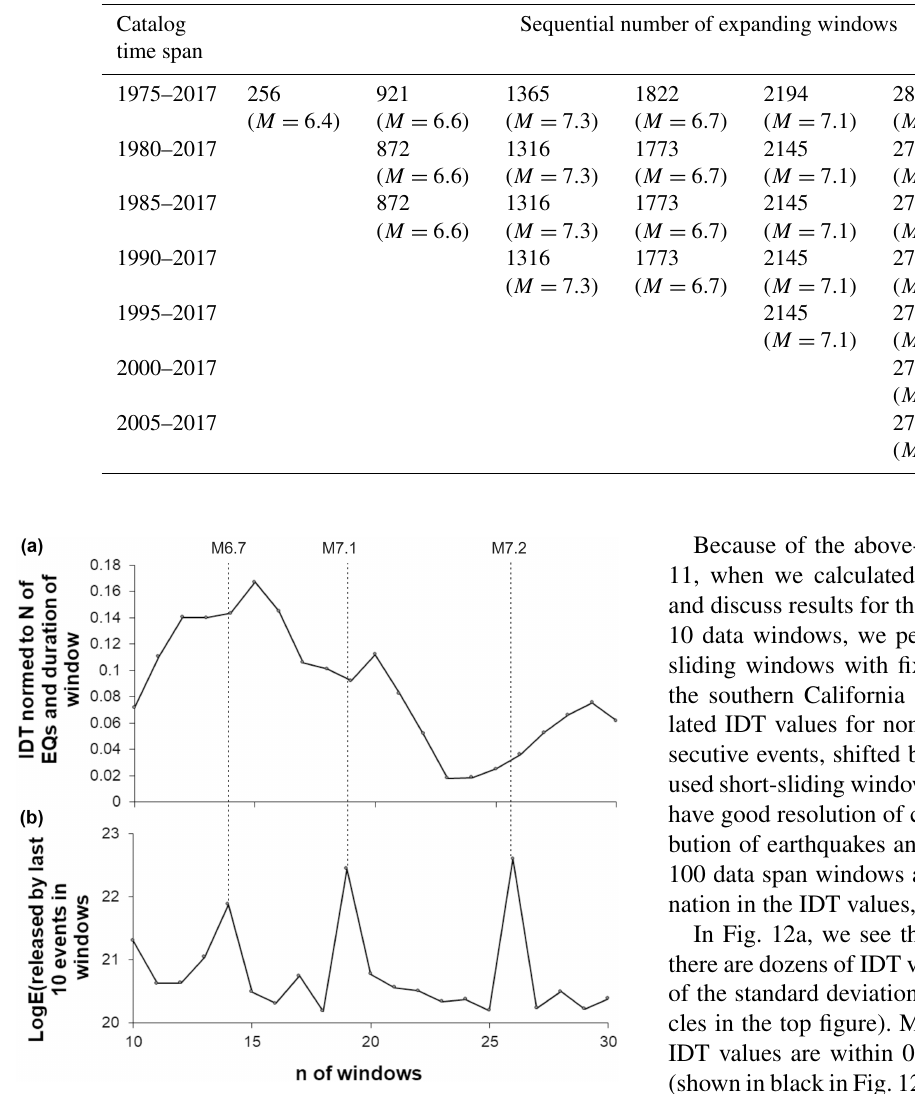
Figure 11. Calculated for the expanding (by consecutive 10 data) windows, integral deviation times (IDTs) (a) and the increments of seismic energies released by 10 last events in consecutive win- dows (b) obtained from the southern California earthquake catalog (above threshold M = 4 . 6). Dashed lines show the occurrence of the largest earthquakes in the